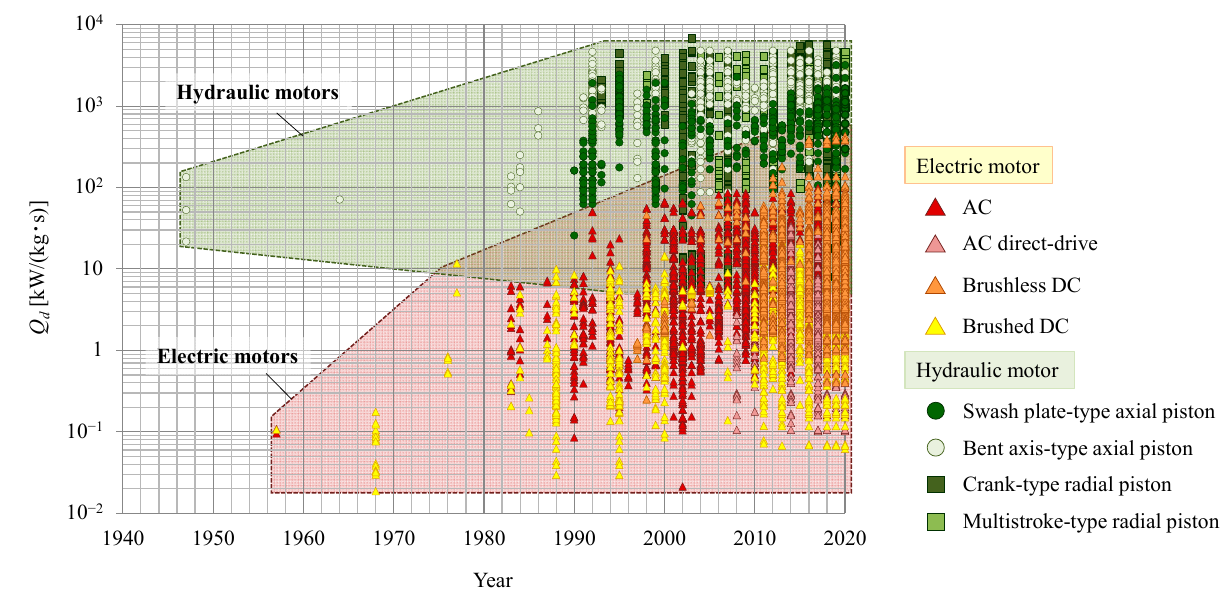
Figure 7. Transition of power rate density.